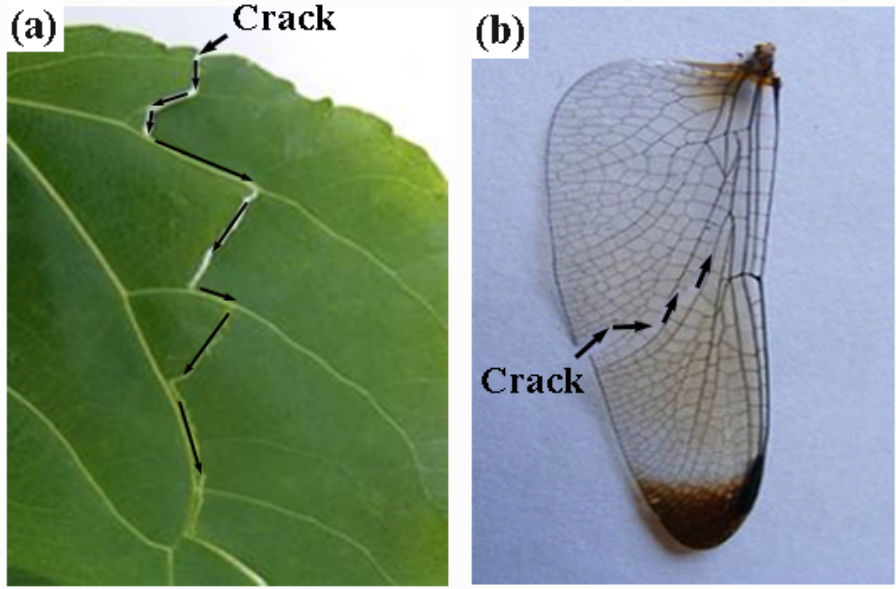
Figure 1. Deflection of crack in the leaf ( a ) and butterfly wing ( b ).